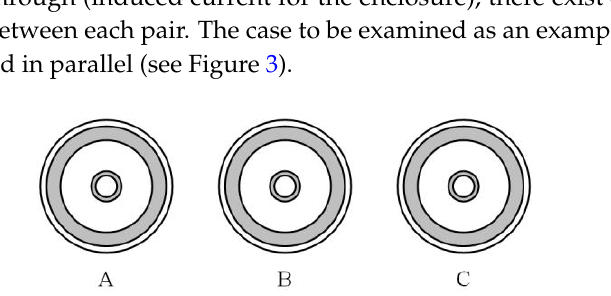
Figure 3. Diagram of a GIL arranged in parallel.